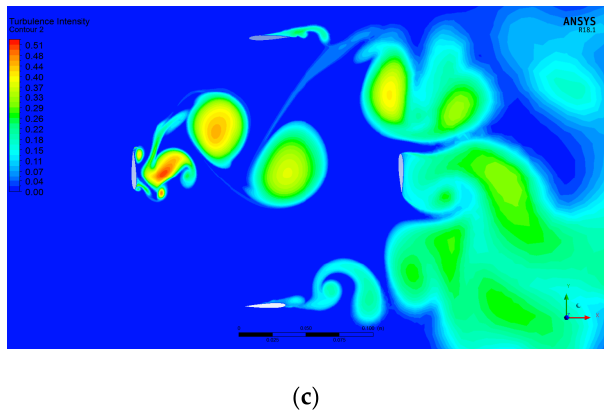
Figure 9. Contours of turbulent intensity for DDES ( a ), RANS Transition ( b ) and RANS SST k-ω ( c ) at 0° azimuthal position at λ max = 0.29.